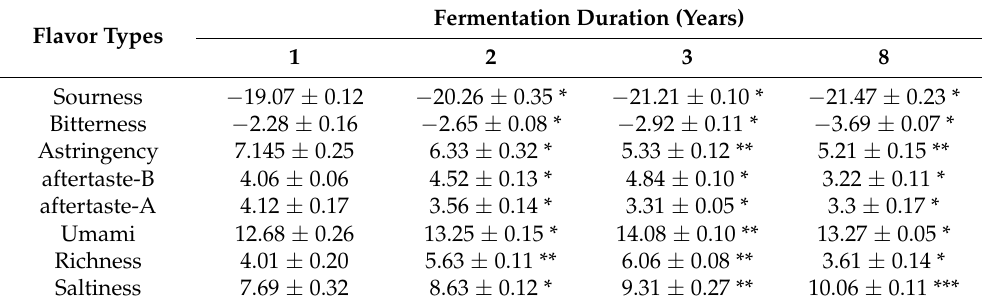
Table 3. Taste types of shrimp paste fermented for 1, 2, 3, and 8 years measured by E-tongue.